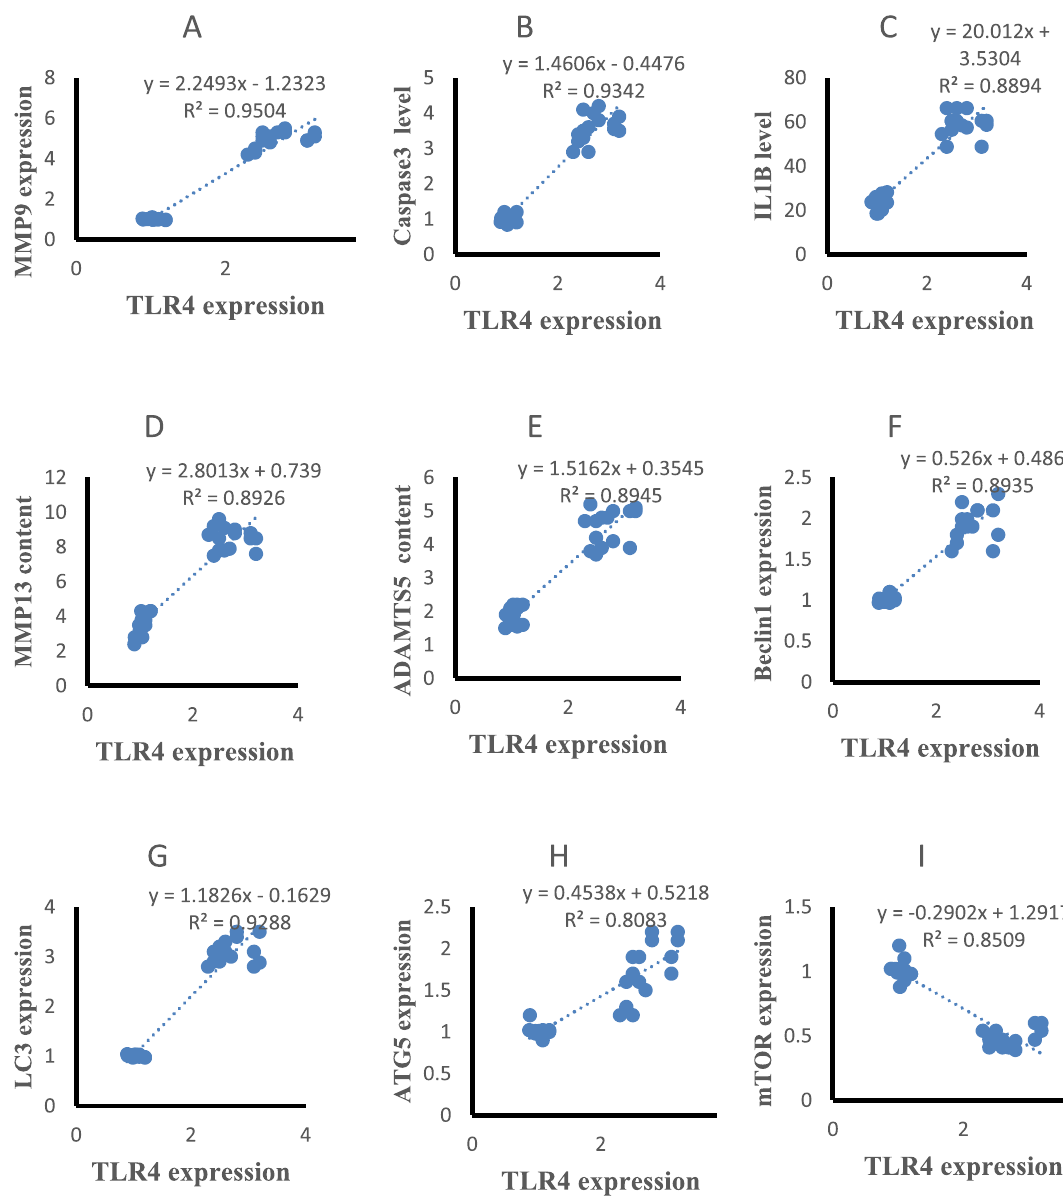
Figure 7. Correlations of cartilage TLR4 expression with other studied parameters in control and HFD